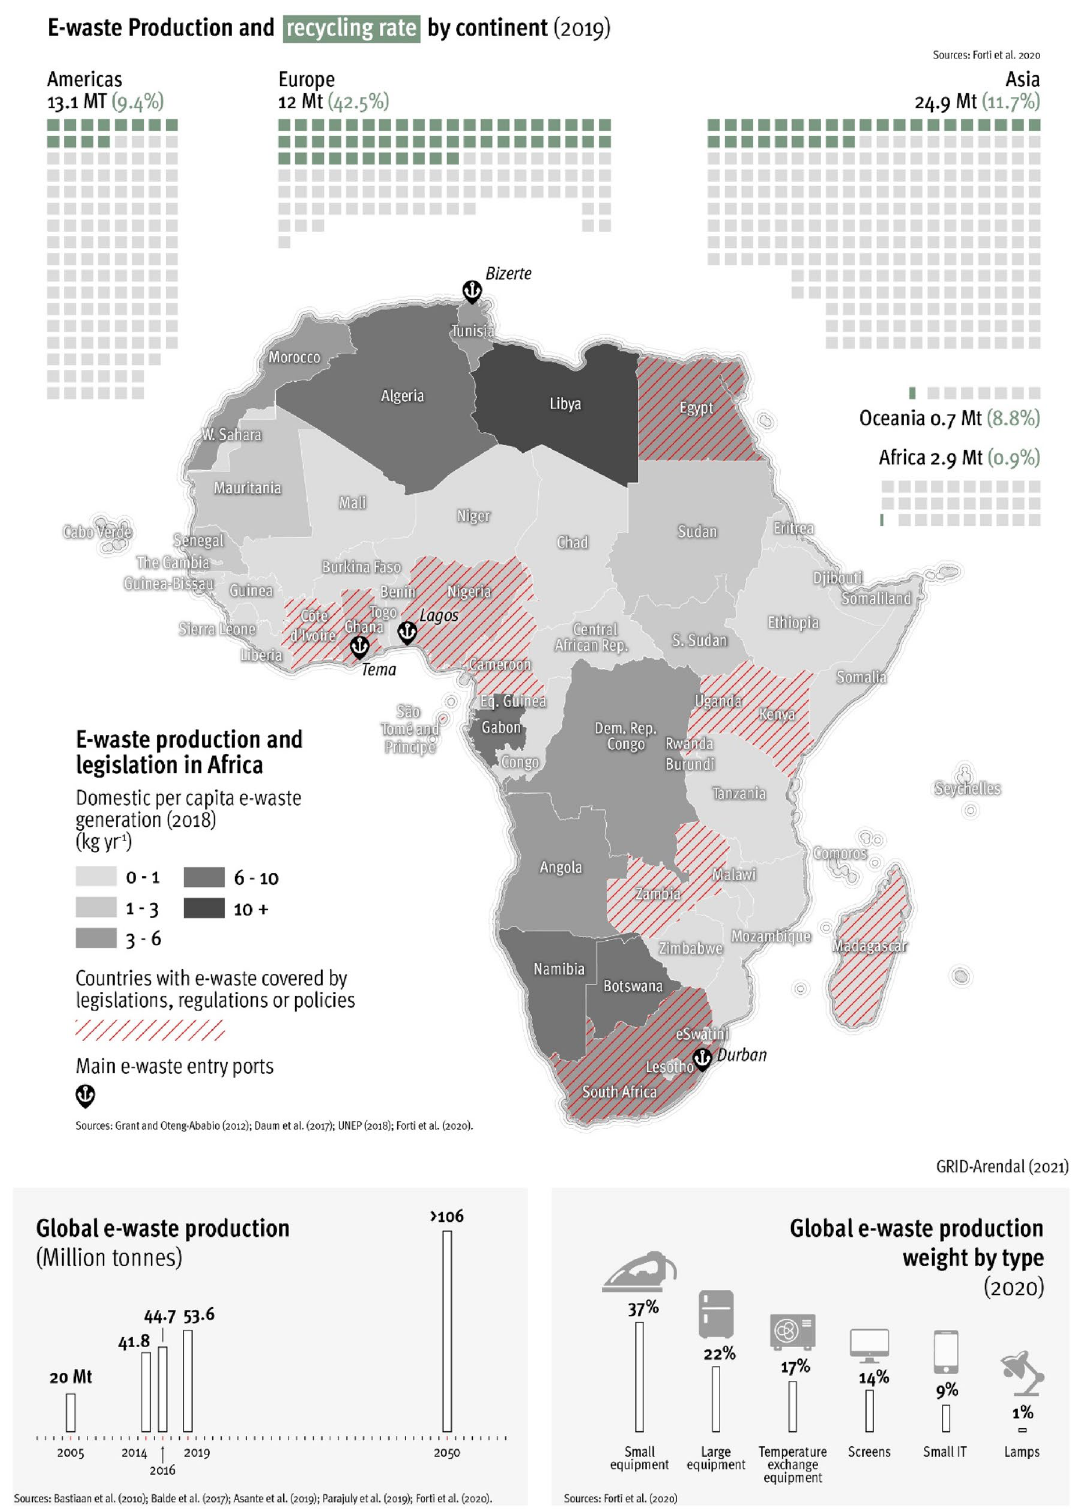
Fig. 1 The African e-waste